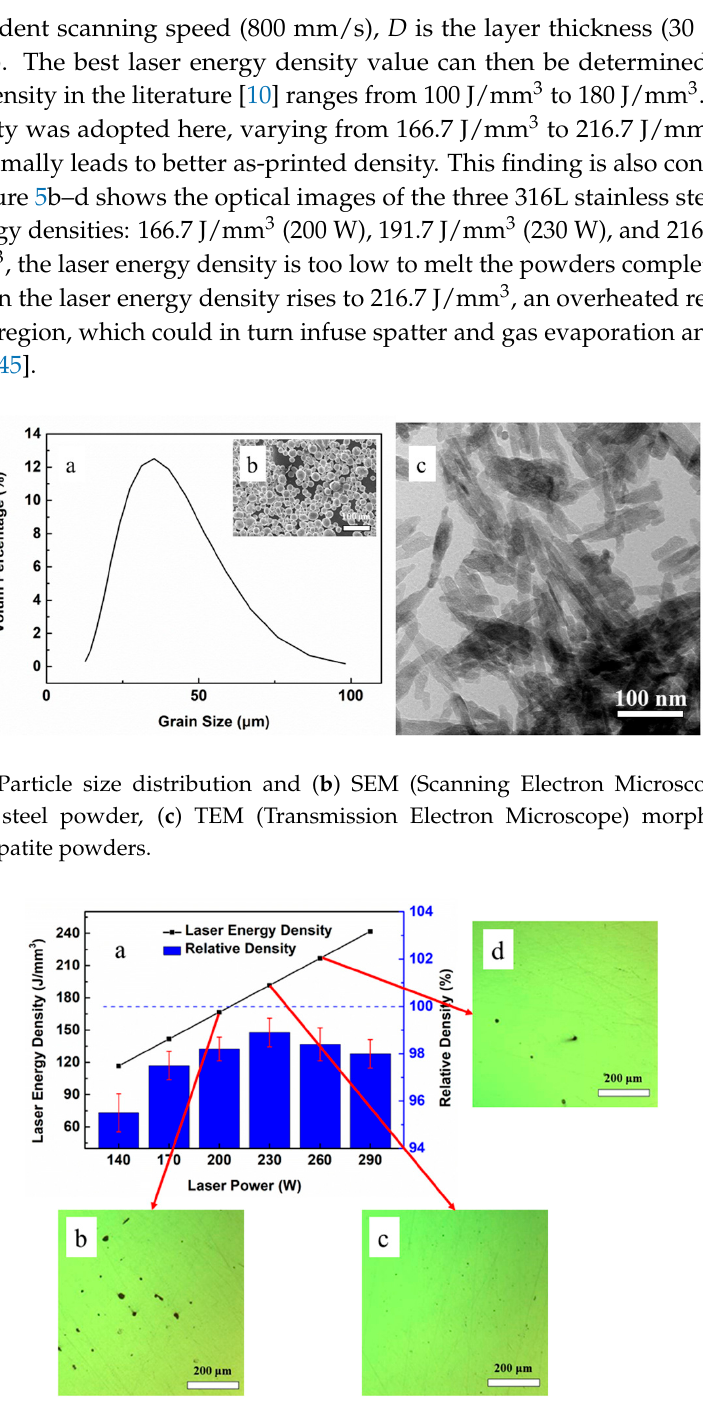
Figure 5. ( a ) Relative density of the 6 samples manufactured by SLM (selective laser melting); Optical microscope images of 316L stainless steel under three different laser energy densities: ( b ) 166.7 J/mm 3 (200 W), ( c ) 191.7 J/mm 3 (230 W), and ( d ) 216.7 J/mm 3 (260 W).